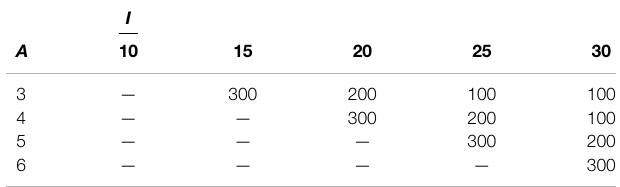
TABLE 4 | Required number of respondents R to achieve a marginal classi fi cation accuracy of0.9 when assessing A attributes with I items ( “ - ” indicates thatthis level of accuracy cannot be achieved with R ≤